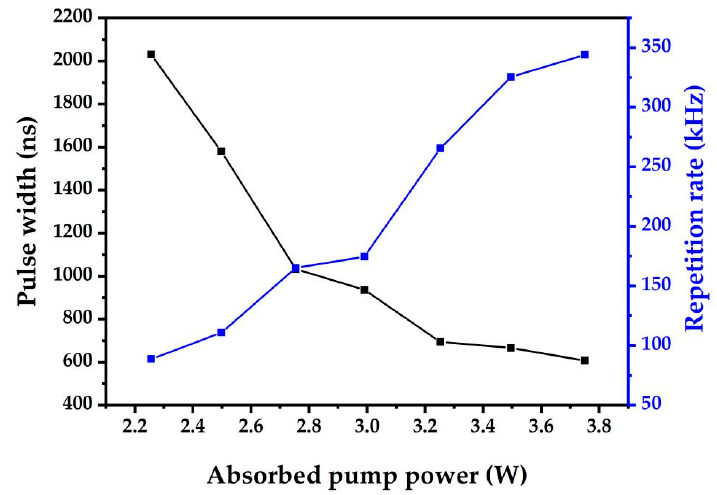
Figure 6. Dependences of pulse width and repetition rate on absorbed pump power.